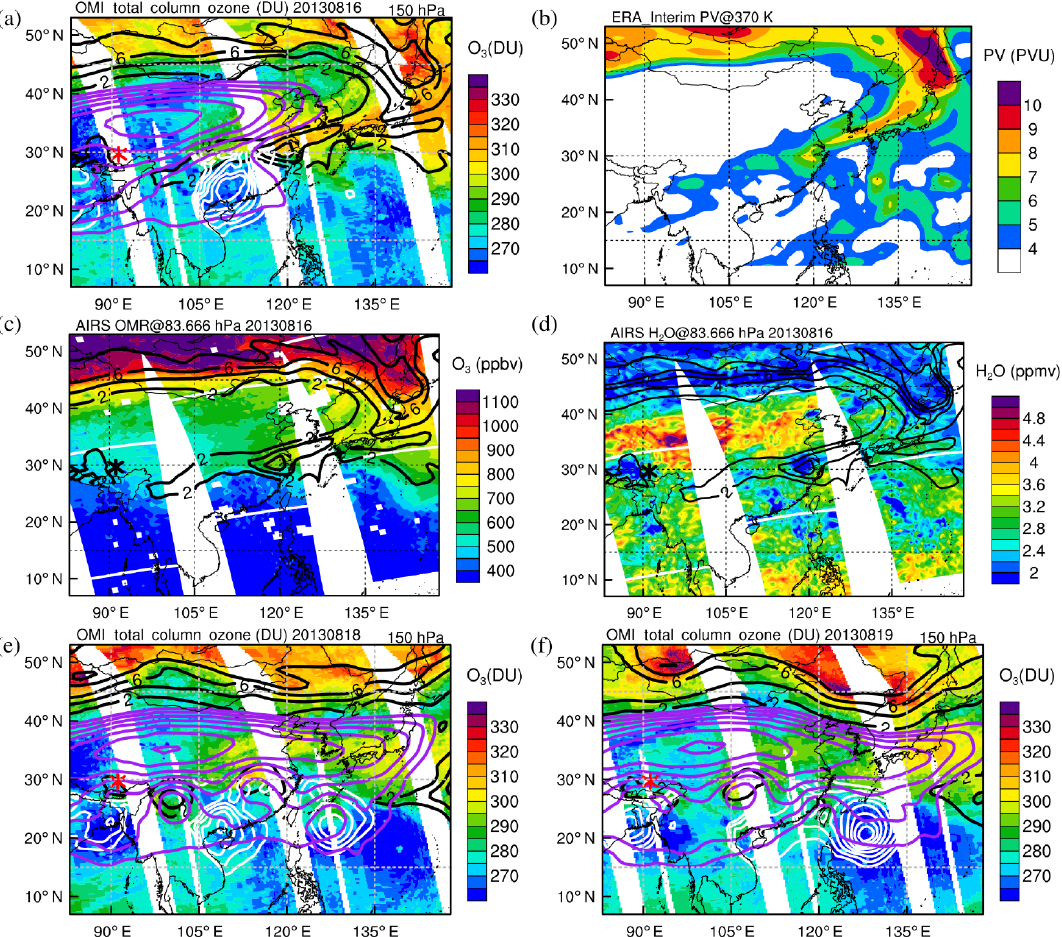
Figure 4. Total column ozone (DU) as measured by OMI with the geopotential height (purple line) and PV (black line, in PVU) at 150hPa, and the sea-level pressure (white line) of tropical cyclone on (a) 16, (e) 18, and (f) 19 August 2013 using ERA-Interim data. (b) The PV (shade, PVU) on the 370K surface on 16 August 2013. (c) Ozone and (d) water vapour mixing ratios for 83.666hPa from AIRS on 16 August 2013 with PV at 150hPa from ERA-Interim. The asterisk marks the location of Lhasa.